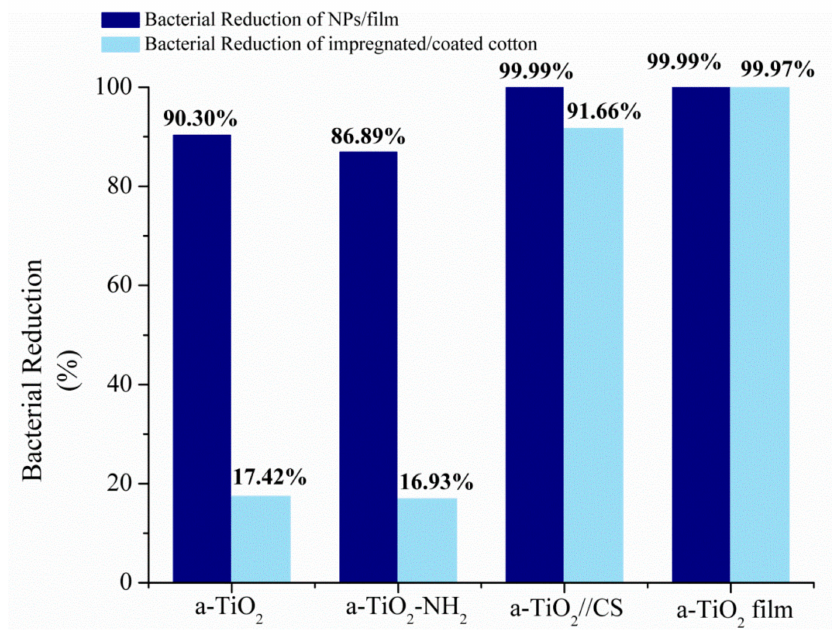
Figure 8. Daylight bacterial reduction of S. aureus achieved by a-TiO 2 NPs / films and impregnated / coated cotton